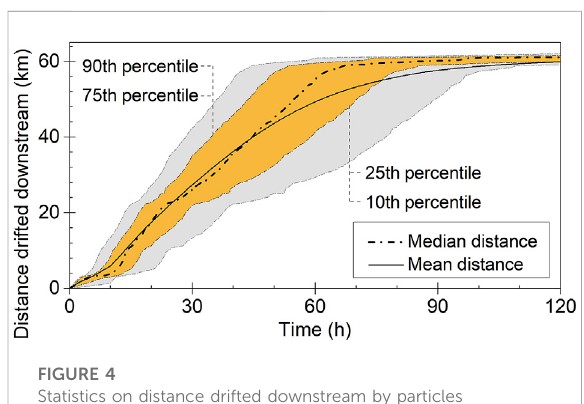
Variation in the center of mass of particle swarm ( Z / H = 1.0 represents the water